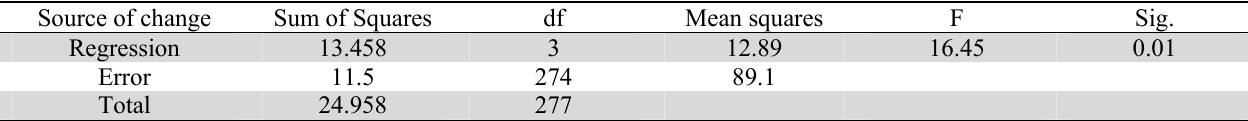
The summary of ANOVA test Source of change